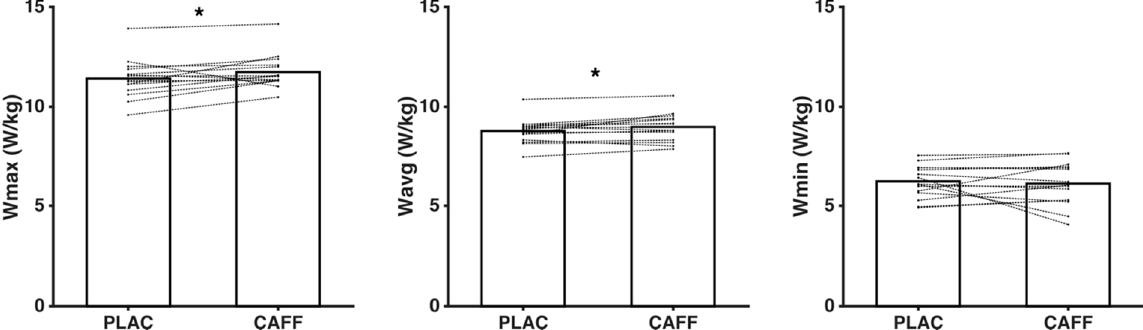
Figure 2. Power (W/kg) variables Wmax, Wavg, and Wmin recorded under placebo and caffeine experimental conditions. PLAC: placebo group; CAFF: caffeine supplementation group. * Significant difference for placebo vs. caffeine ( p < 0.05).